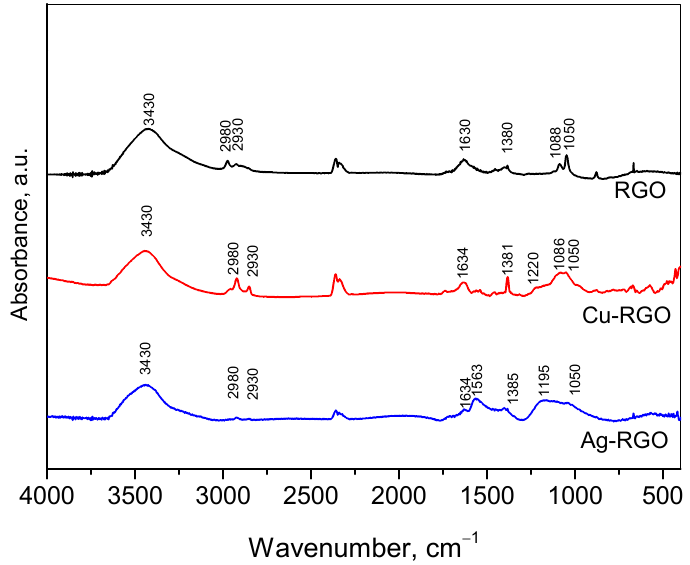
Figure 5. FTIR spectra of RGO, Cu–RGO/Cu and Ag–RGO.